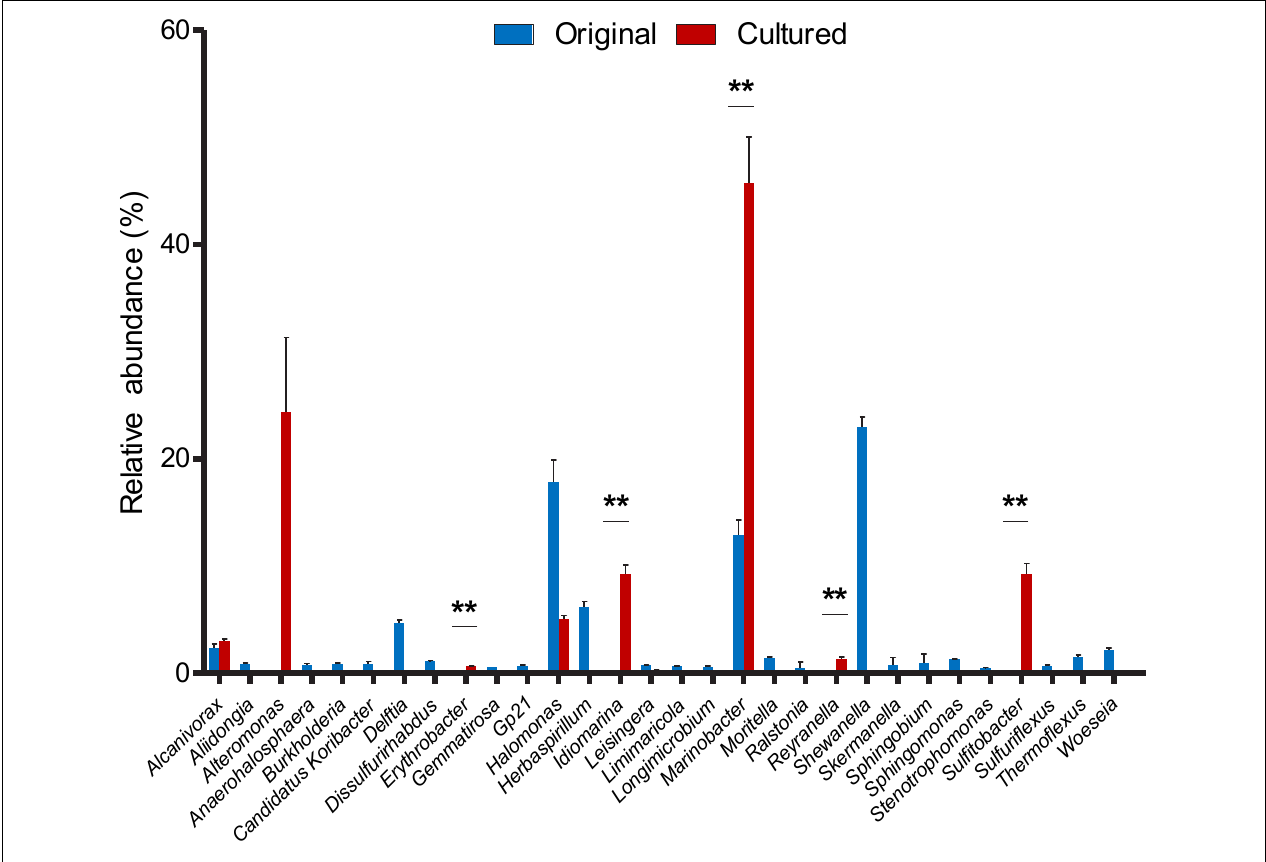
FIGURE 3 | Relative abundance of the 30 most abundant genera in the original and cultured sediment samples. Mean values and standard errors are shown. “**” represents p -value < 0.01 produced by two-tailed Student’s t